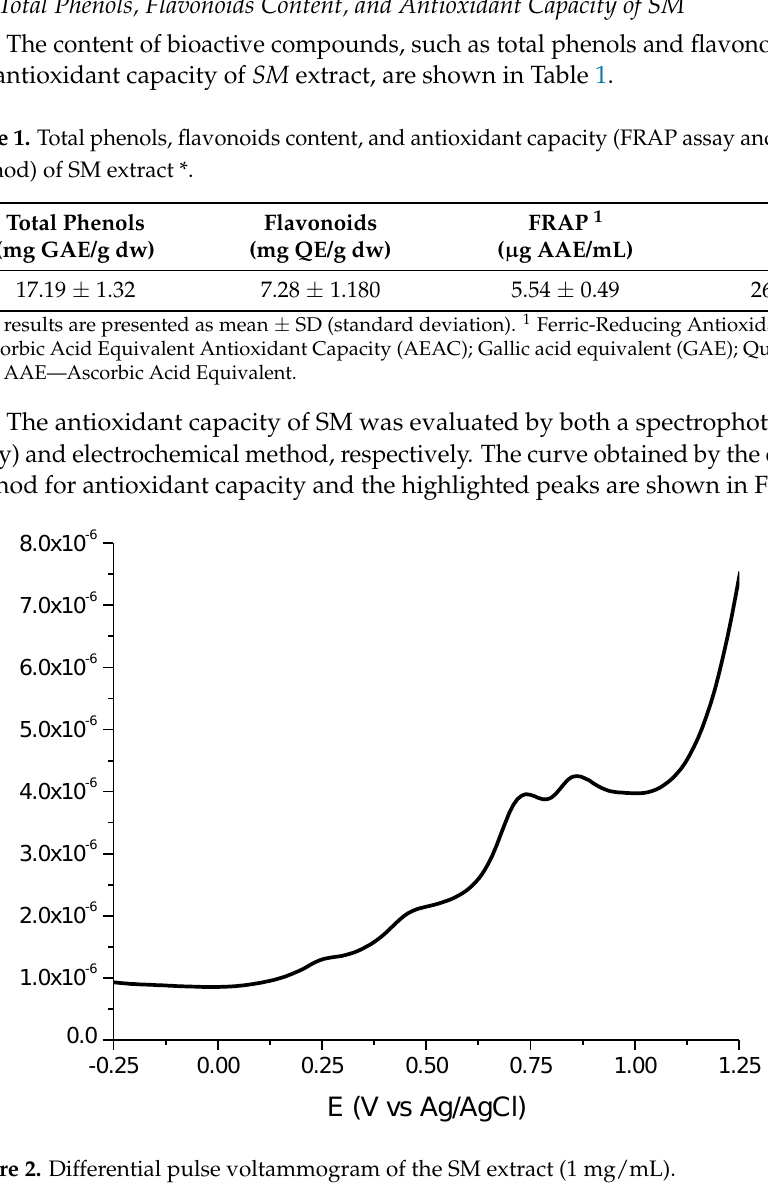
Table 1. Total phenols, flavonoids content, and antioxidant capacity (FRAP assay and electro- chemical method) of SM extract *.